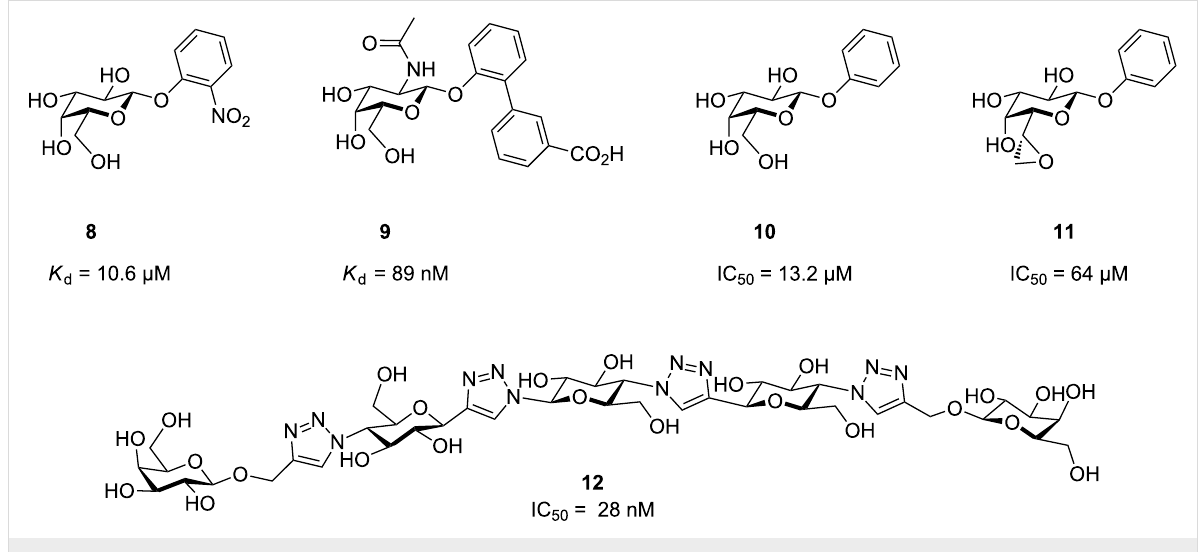
Figure 2: Galactosides targeting uropathogenic Escherichia coli FmlH (compounds 8 and 9 ) and Pseudomonas aeruginosa LecA (compounds 10 – 12